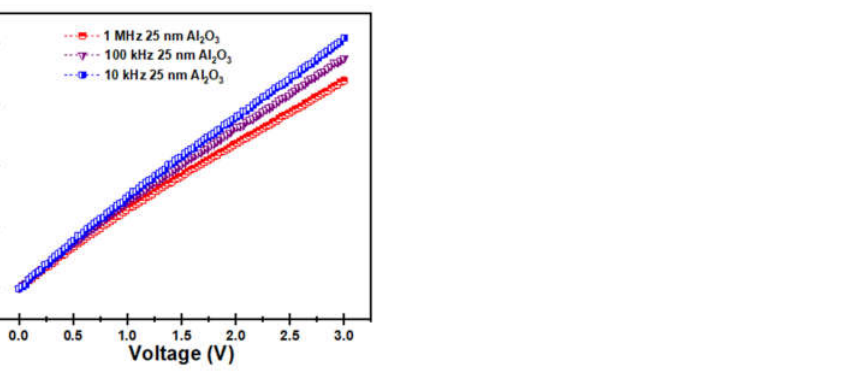
Figure 7. Normalized capacitance as the function of bias voltage of 25 nm Al 2 O 3 capacitors at 10 4 Hz, 10 5 Hz, and 10 6 Hz, respectively. 10 5 Hz, and 10 6 Hz,